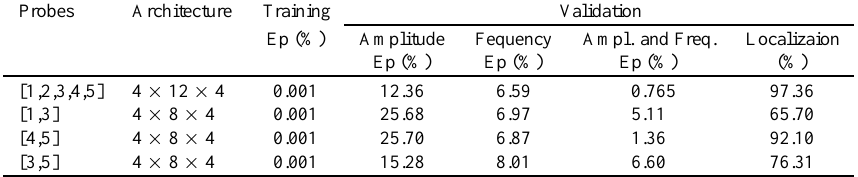
Table 3 Training and validation results for the asynchronous forces identification neural